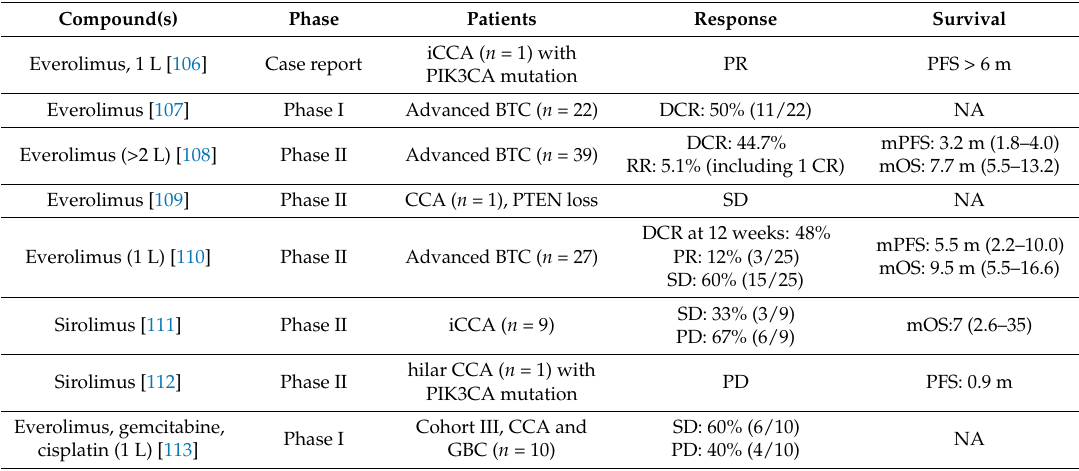
Table 1. Summary of published data regarding mTOR inhibitors in advanced